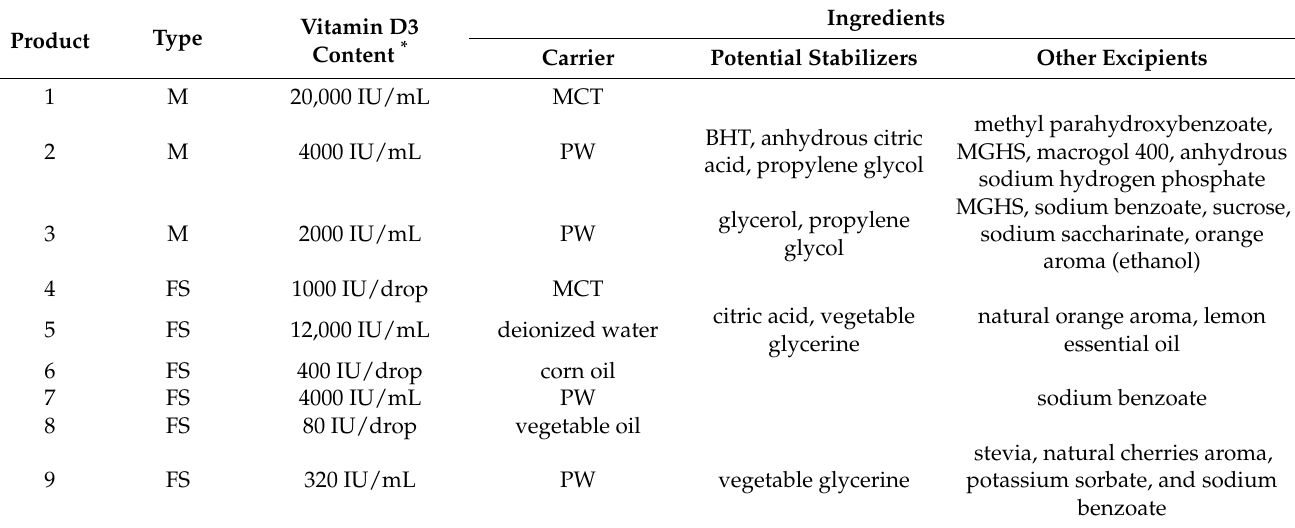
Table 2. Data on the tested